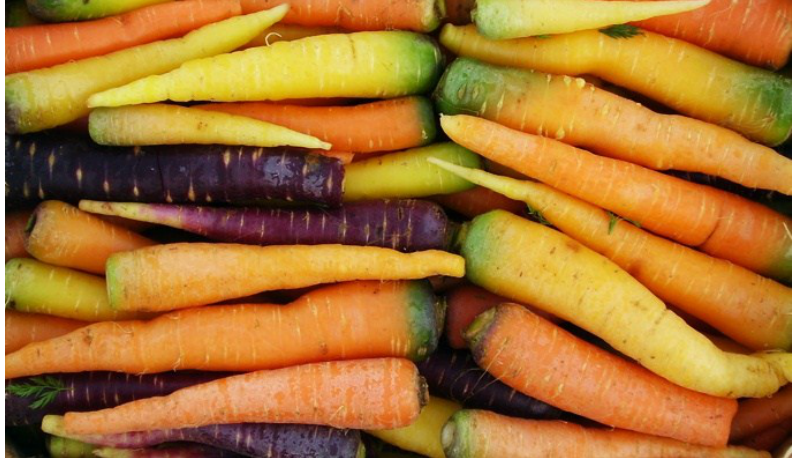
Figure 14. Polignano carrots ready for market: it is interesting to note the great variety of the root colors.